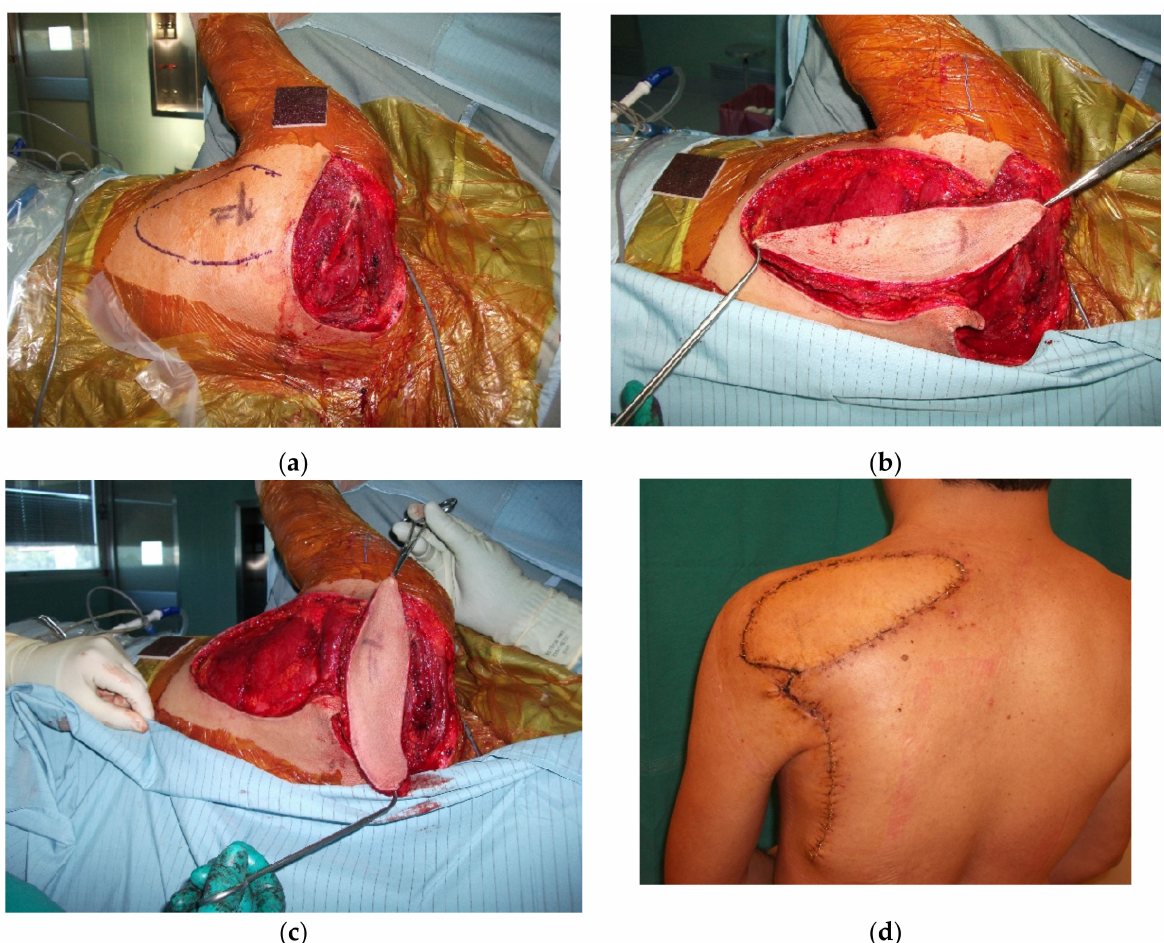
Figure 6. Raising of the pedicle from the circumflex scapular artery has been used in the past to supply the scapular and the parascapular free flaps. On the same perforator, a propeller flap can be elevated to cover more proximal defects, such as in the case shown here after the excision of a dermatofibrosarcoma. ( a ) The residual defect in the scapular region; ( b ) the flap elevated on the per‑ ◦ forator of the circumflex scapular artery; ( c ) 90 rotation of the flap; and ( d ) two‑week post‑operative follow‑up. The donor site is closed